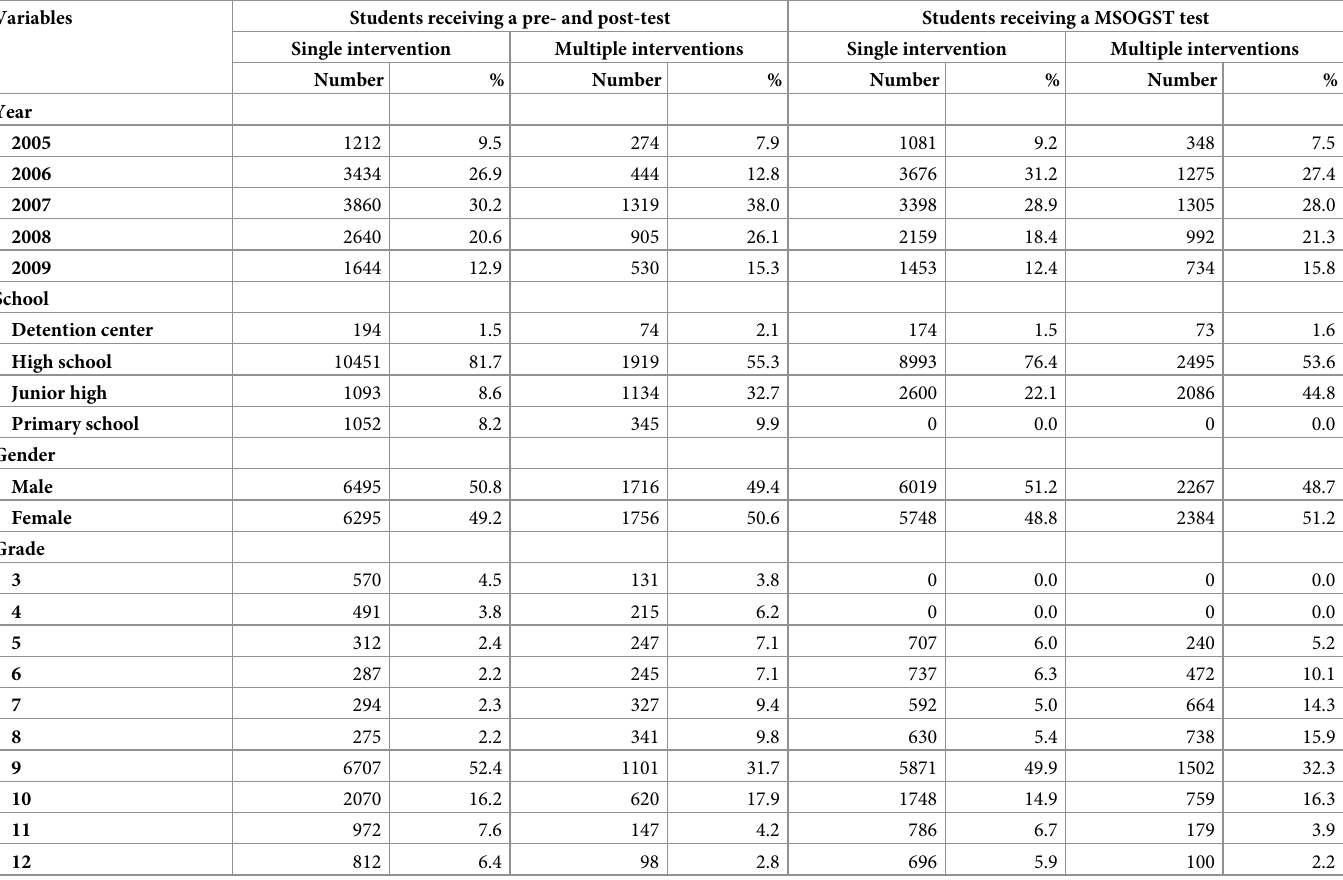
Table 1. Demographics of students in the analysis. MSOGST, Modified South Oaks Gambling Screen for Teens.